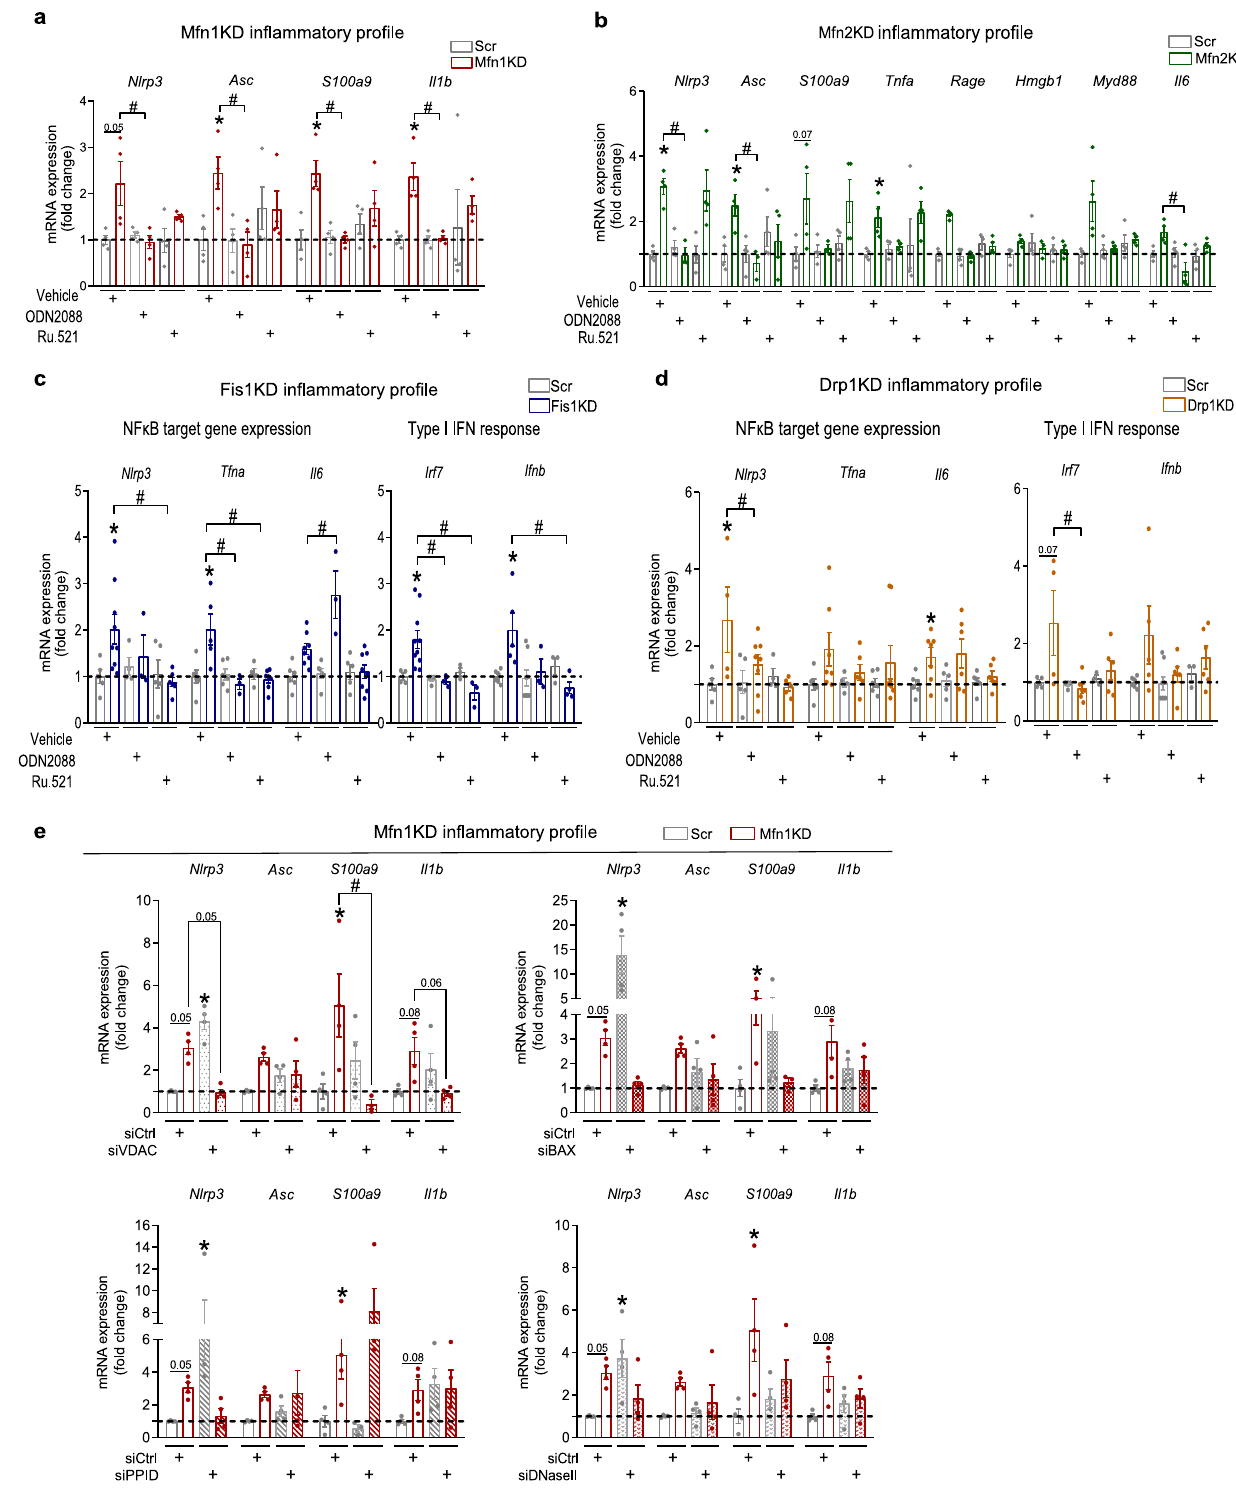
Fig.3|BlockadeofDNAsensorsrescuesthein fl ammatorypro fi leuponaltered mitochondrial dynamics. a In fl ammatory pro fi le in Mfn1KD myoblasts upon ODN2088 or Ru.521 treatment (1 µ M, 24h) ( n =4). b In fl ammatory pro fi le in Mfn2KD myoblasts upon ODN2088 or Ru.521 treatment (1 µ M, 24h) ( n =4). c In fl ammatory pro fi le in Fis1KD myoblasts upon ODN2088 or Ru.521 treatment (1 µ M, 24h) ( n =8). d In fl ammatory pro fi leinDrp1KDmyoblasts upon ODN2088